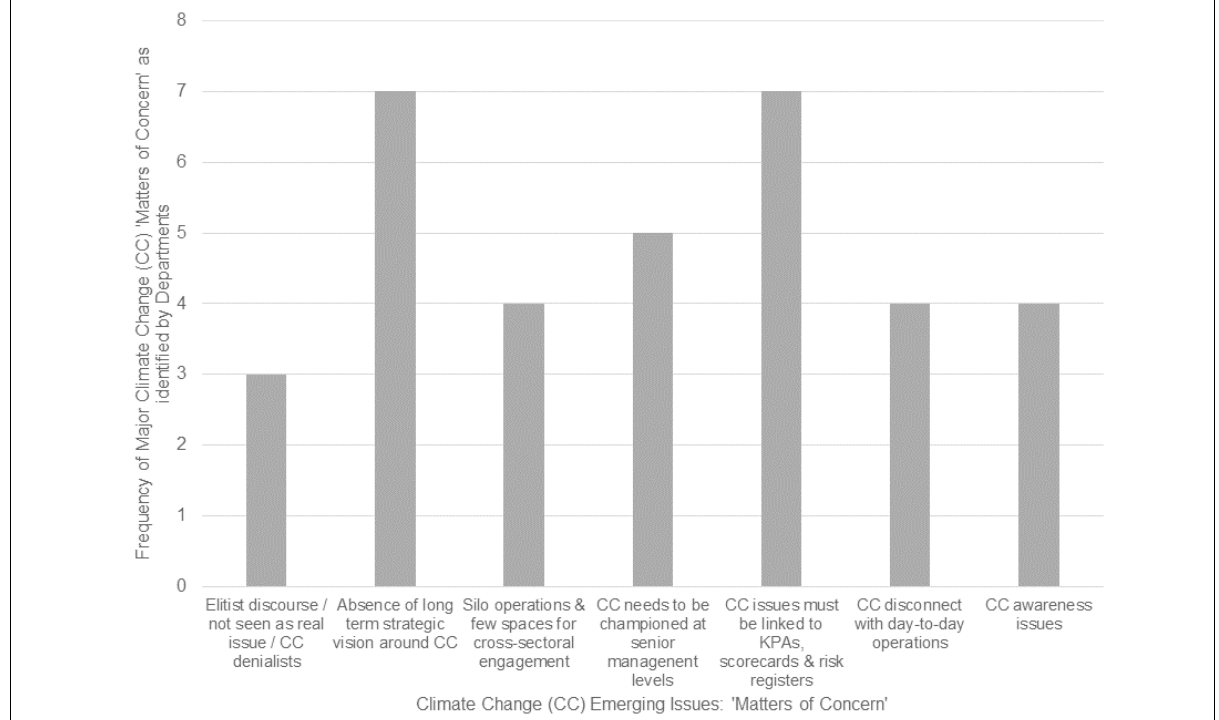
Figure 6: Emerging issues (‘matters of concern’) seen as potential barriers to operationalising climate change (‘CC’) in the City of Johannesburg’s (CoJ) activities. Climate change related emerging Issues were thematically coded from individual one-on-one interviews conducted with representatives of different CoJ Departments (City Parks, Environment and Infrastructure Services Department, Development Planning, Disaster Management, Johannesburg Water, Environmental Health Department, Johannesburg Road Agency). Frequency is the aggregated count of themes that emerged from interview data across all